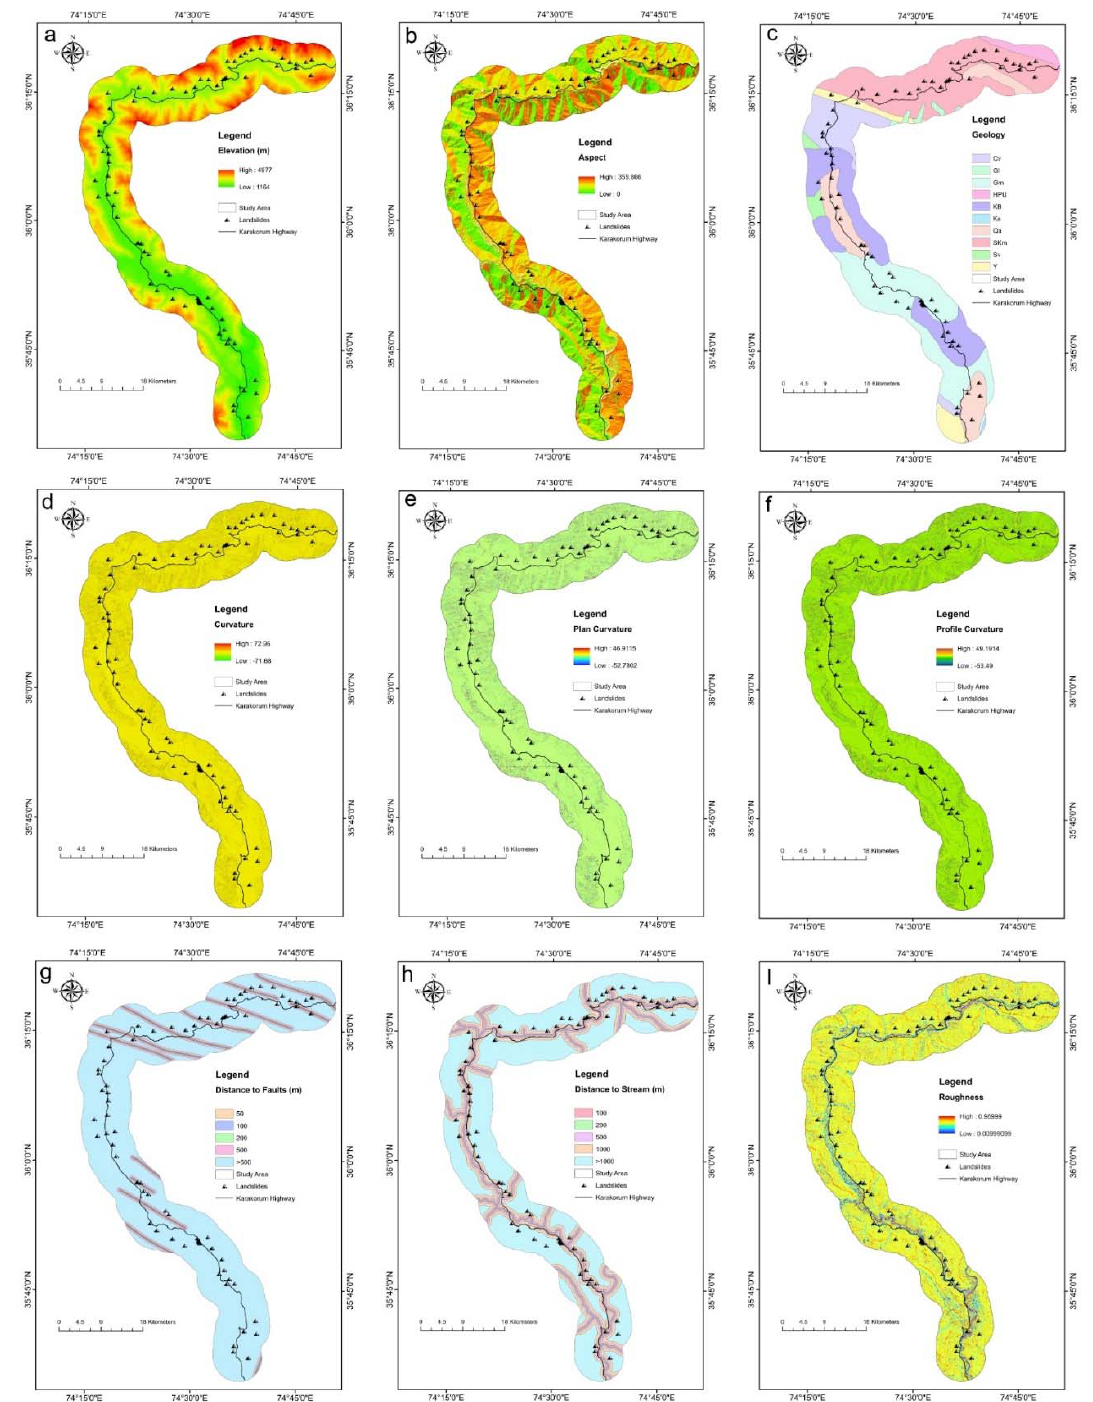
Figure 5. Landslide variables. ( a ) Elevation, ( b ) aspect, ( c ) geology, ( d ) curvature, ( e ) profile curvature, ( f ) plan curvature, ( g ) distance to faults, ( h ) distance to streams, ( I ) roughness .